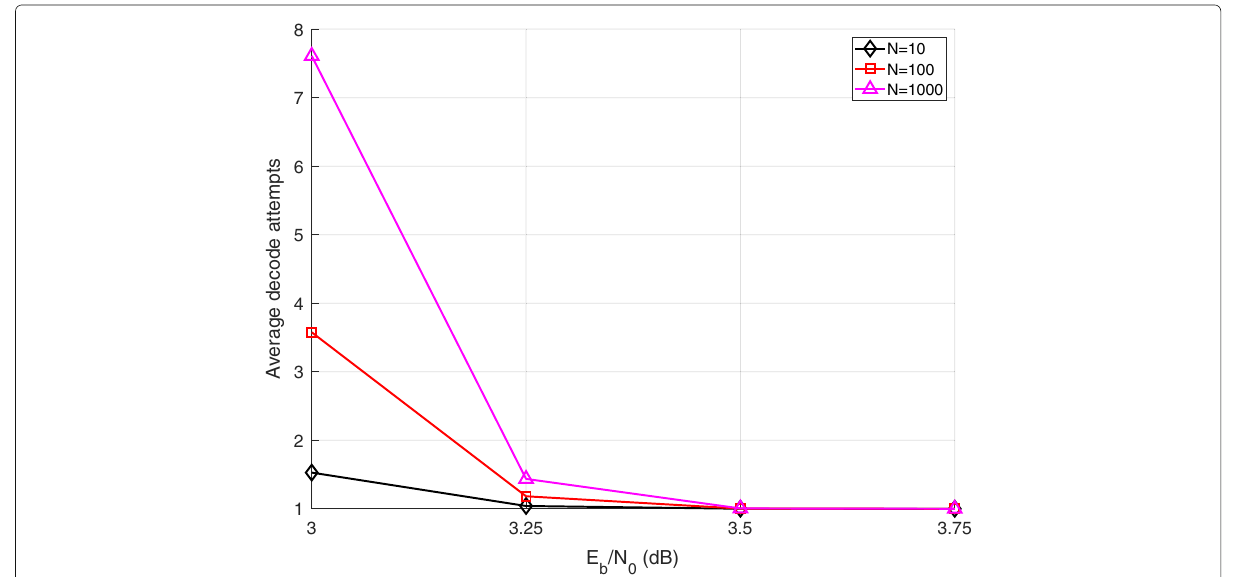
Fig. 5 Quasi-regular decoding attempts plot. Average number of decoding attempts of augmented decoders for the n = 4095 and R = 0.82 quasi-regular